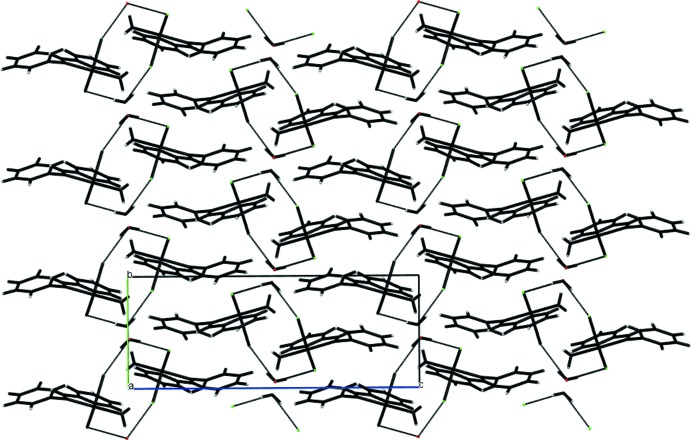
The crystal packing in a view along the a
+
b vector showing the stacking of symmetric cyclic dimers.